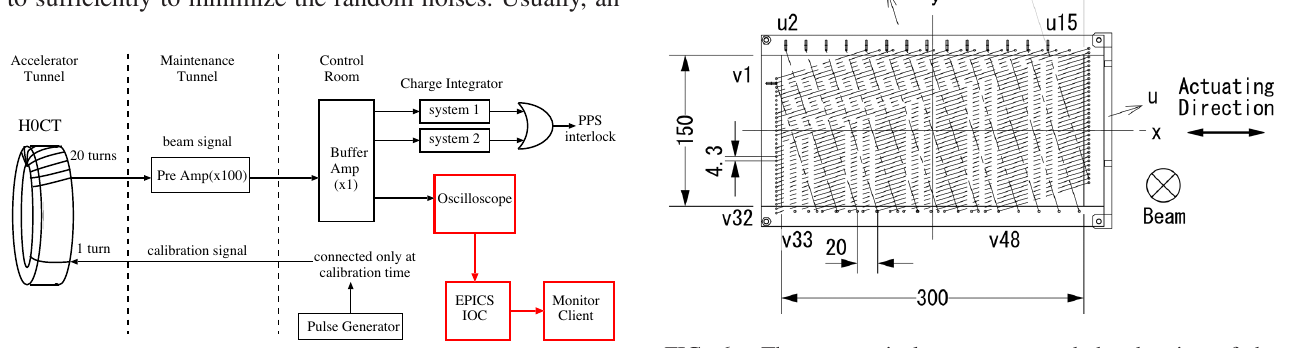
FIG. 5. A schematic drawing of the CT configuration and data taking logic. A two-stage amplified buffered signal was fed to an oscilloscope and controlled through an OPI.